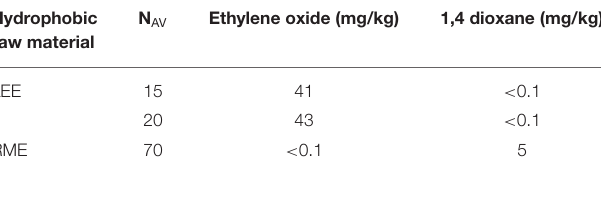
TABLE 4 | The content of harmful substances in selected ester oxyethylates. Hydrophobic raw material